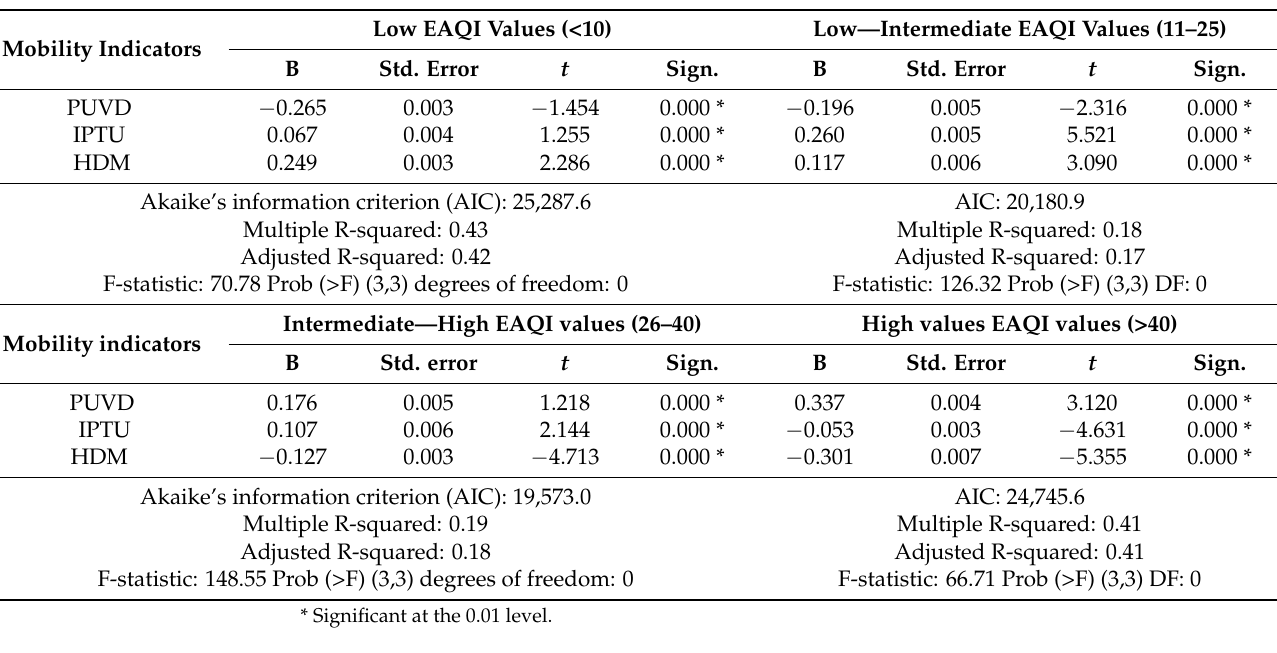
Table 3. Detailed multiple regression models (OLS) for LISA bidimensional analysis of the different levels of air quality index.